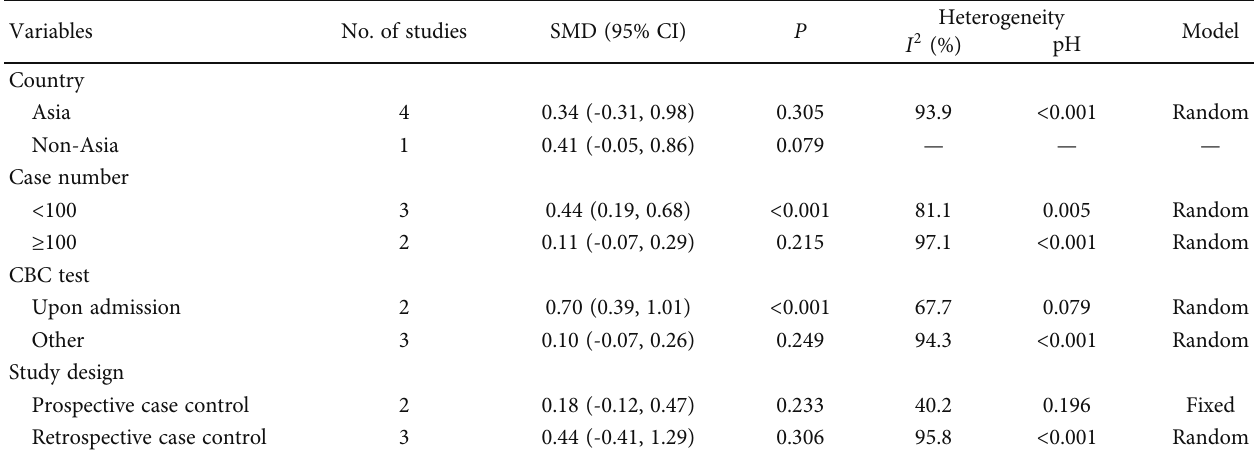
Table 3: LMR subgroup analysis.